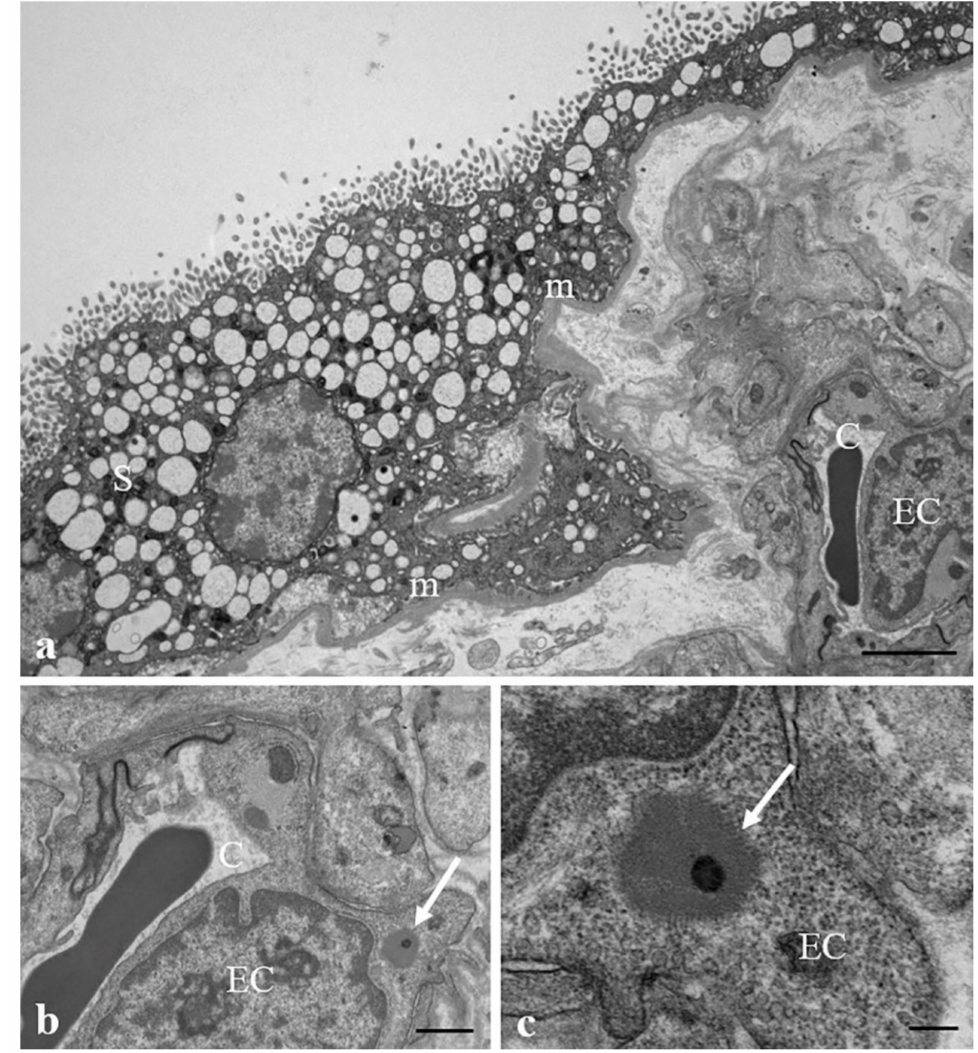
Figure 7. MPs and narrowing of the fetal capillaries. ( a , b ) Transmission electron micrographs of a narrowing of the fetal micro-vessel (C) in association with ( b , c ) the presence of a MP (arrow) inside the cytoplasm of an endothelial cell (EC). Bar, 2 µ m ( a ), 800 nm ( b ), 200 nm ( c